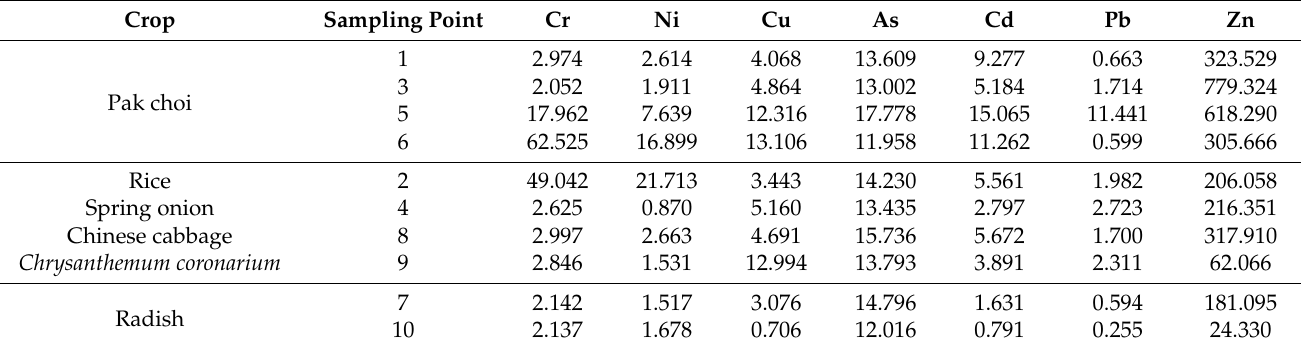
Table 6. Heavy metal concentrations in crops